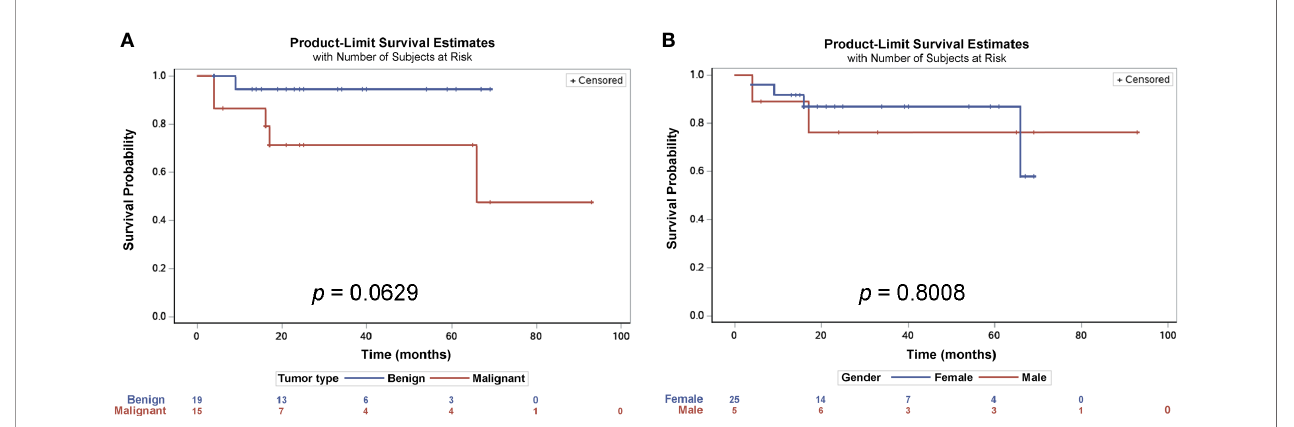
FIGURE 4 | Survival probability estimates of patients with presacral tumors. Kaplan-Meier estimates analysis showed that there was a trend for patients with benign tumors having a longer survival rate, though not statistically signi fi cant (A) , but there were no differences between male and female patients (B)